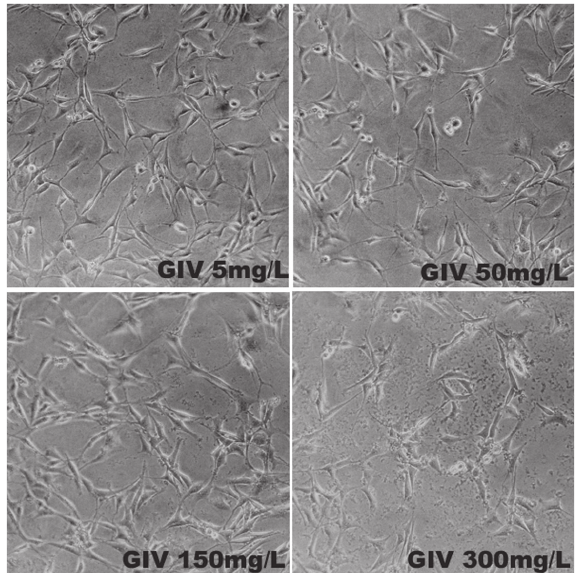
Figure 5- Photomicrographs of Group IV (Metronidazole) at 72